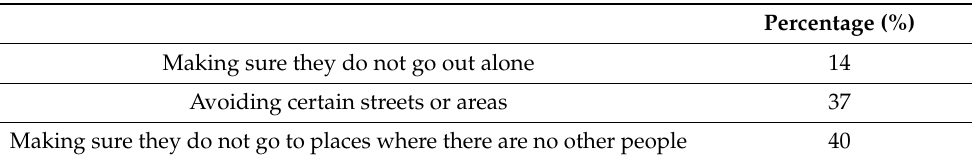
Table 1. Public places or situations that women avoid, at least sometimes, out of fear of being victims of physical or sexual